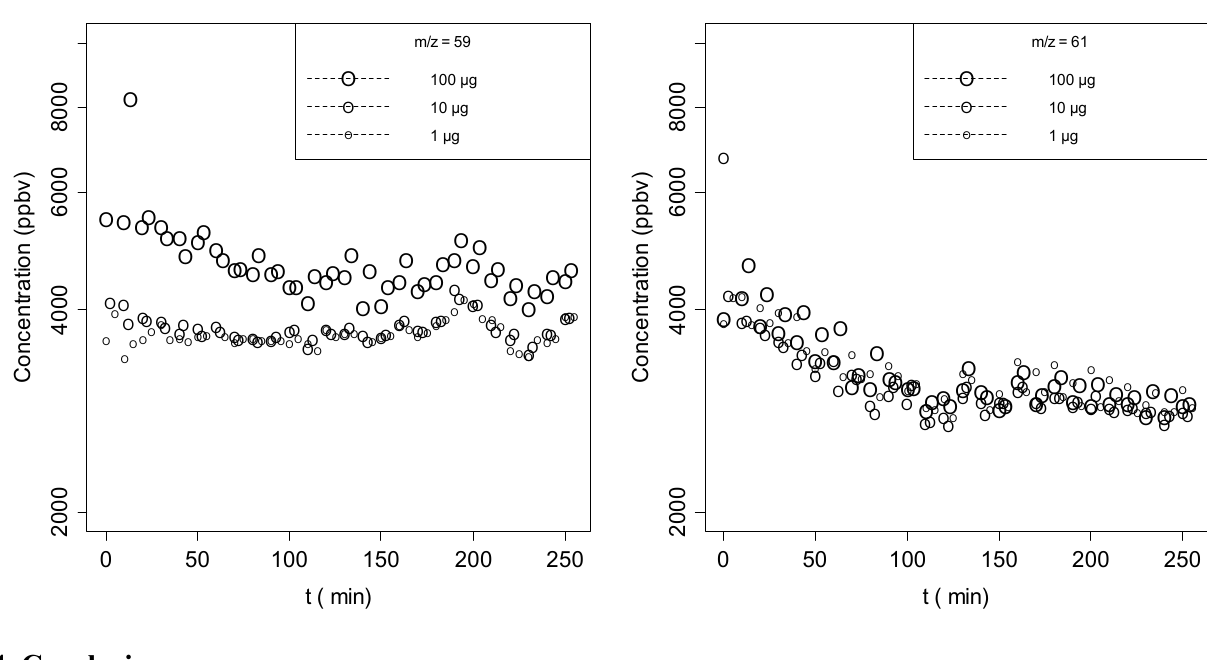
Figure 6. Time evolution of possible